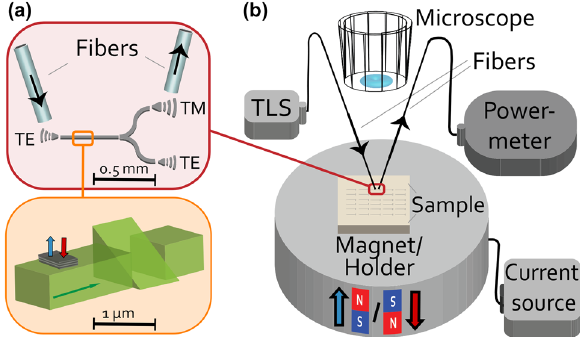
Figure 2: (a) A schematic of the proof-of-principle type, stand-alone magneto-photonic device. Top: Overall device with mode-selective (TE and TM) grating couplers, waveguides and splitters are shown. Bottom: A zoom-in view of the core-module, showing the memory component (top-cladding) and the polarization rotator (triangular waveguide). (b) The optical transmission measurement set-up. A tunable laser source (TLS) sends the light ( 𝜆 = 1550 nm) through the input fiber. After transmission through the device, the output fiber collects the light and directs it to the optical power meter. The sample holder is an electro-magnet that can apply up to ± 300 mT perpendicular magnetic field, setting the magnetization direction of the memory component on-demand. The fibers are not polarization maintaining and are cleaved to enable an easier